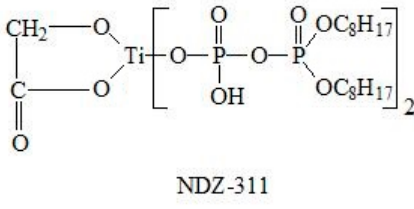
Figure 9. The structural formula of NDZ-311.